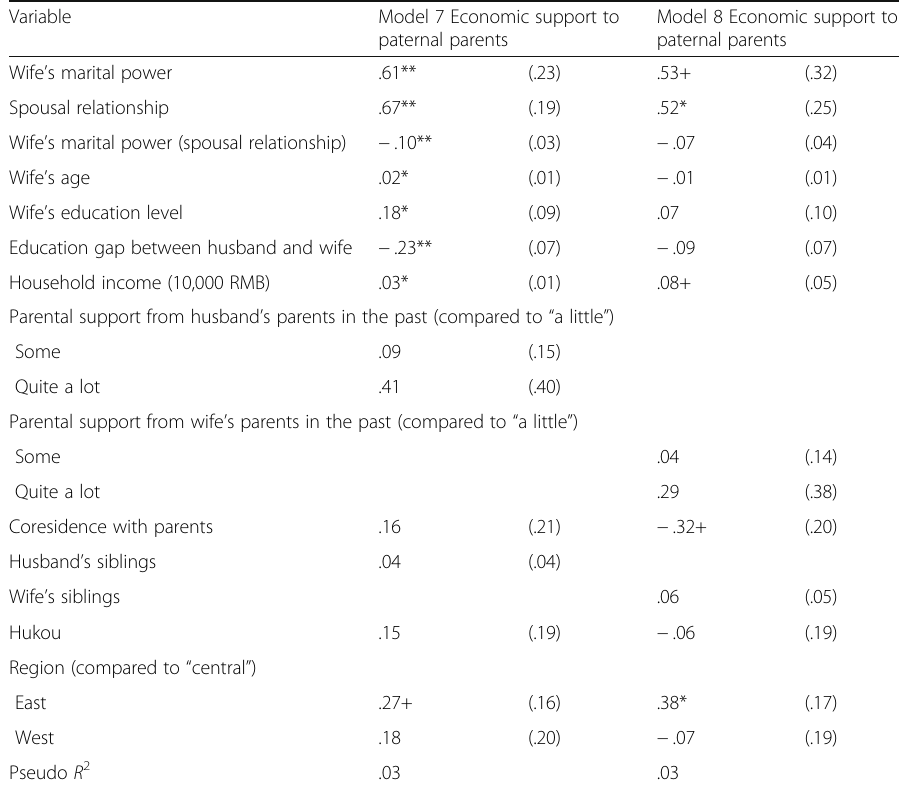
Table 4 The interaction of women ’ s marital power and the spousal relationship on intergenerational support in the family N = 1139 Variable Model 7 Economic support to paternal